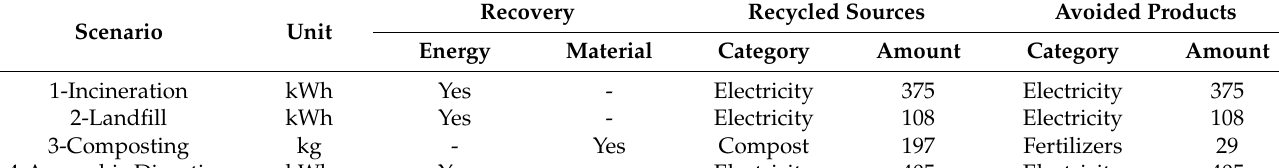
Table 1. Evaluation conditions about recycling energy or material and quantification of the avoided products related to the functional unit of 1 metric ton of kitchen waste treated.